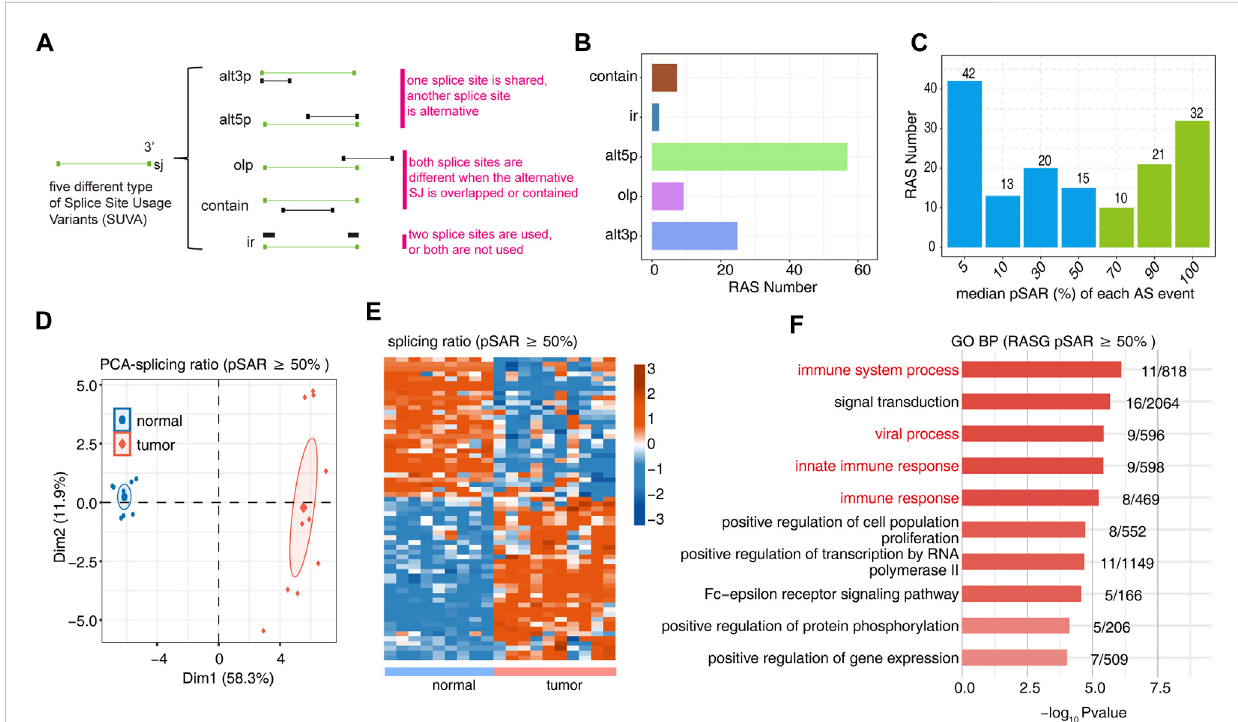
FIGURE 1 Identi fi cation of RAS events between tumor and normal tissues. (A) Five different types of AS event models. (B) Barplot showing the number of regulatoryASdetectedbySUVAineachgroup. (C) BarplotshowingtheRASnumberwithdifferentpSAR.RASwithpSAR(readsproportionoftheSUVAAS event) ≥ 50% were labeled. (D) Principal component analysis (PCA) based on RAS of pSAR ≥ 50%. The ellipse for each group is the con fi dence ellipse. (E) Heatmap presenting fi ve classes of RAS (pSAR ≥ 50%). (F) The top 10 most enriched GO terms (biological process) were illustrated for RAS (pSAR ≥ 50%) genes in the tumor vs. normal group. The color scale showing the row-scaled signi fi cance (-log10 corrected p -value) of the